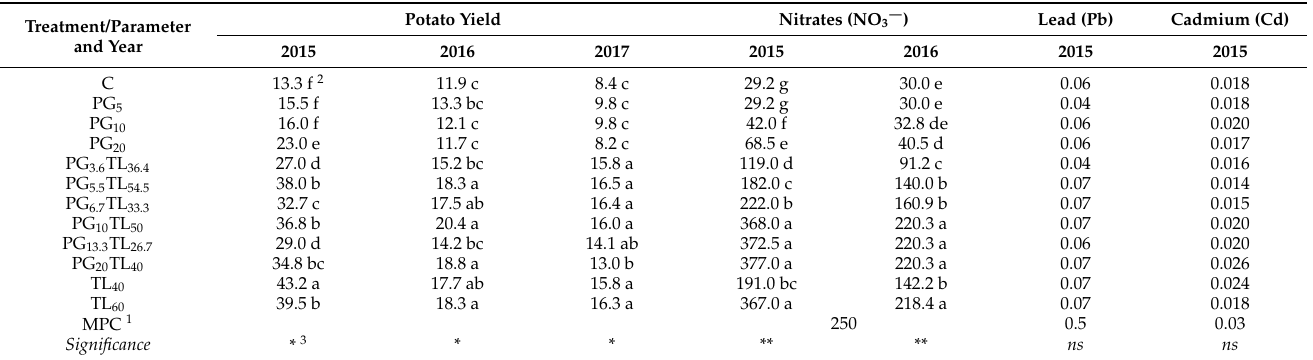
Table 16. Effect of treatments and years on potato yield (t ha –1 ); content of nitrates, lead and cadmium in potato tubers (mg · kg –1 dry